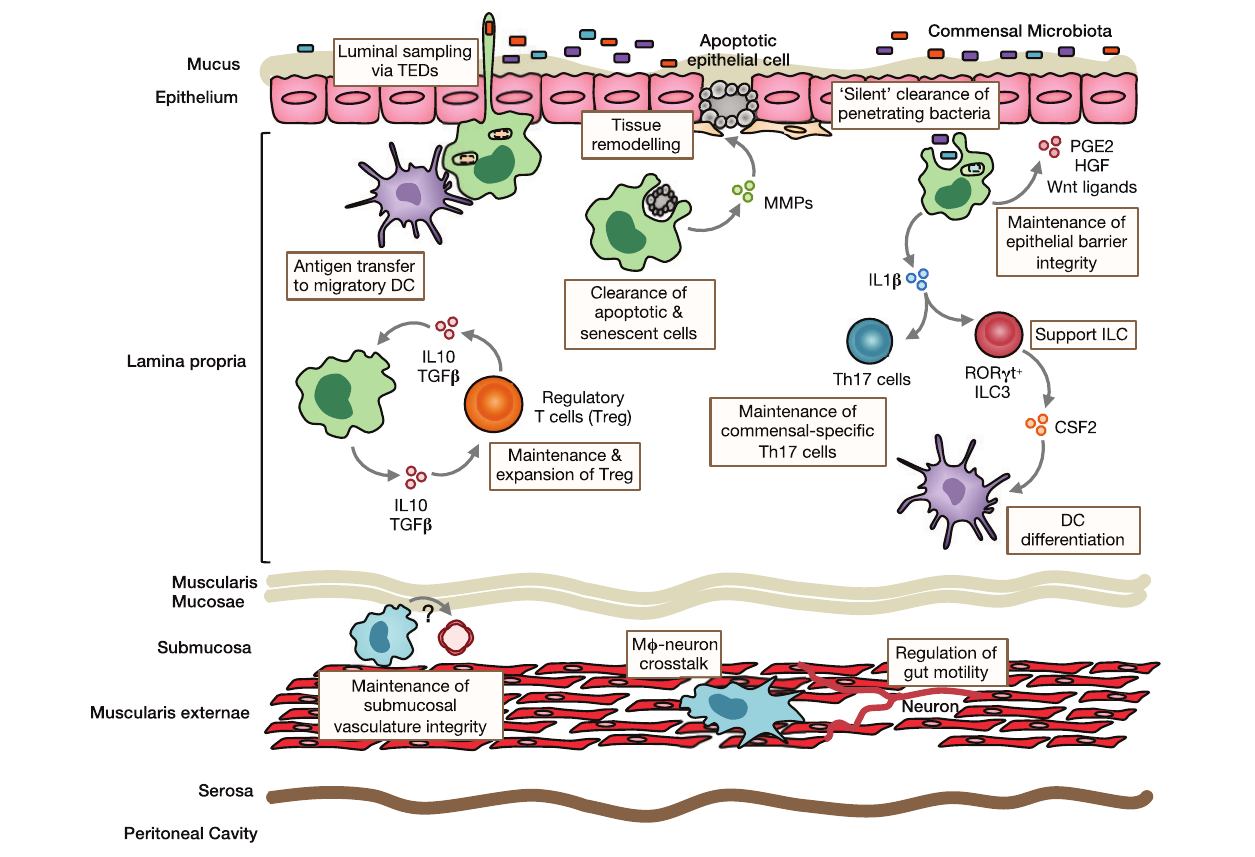
FIGURE 1 | Homeostatic functions of intestinal macrophages. Intestinal lamina propria (LP) macrophages are highly phagocytic and are responsible for clearing apoptotic and senescent epithelial cells. Through their expression of tissue-remodeling metalloproteinases and secretion of factors that stimulate epithelial stem cell renewal, such as prostaglandin E2 (PGE2), hepatocyte growth factor (HGF) and Wnt ligands, they promote epithelial integrity. Their position under the epithelial monolayer and their bactericidal activity, mean LP macrophages are ideally placed to capture and destroy any bacteria that breach the barrier. They may also send cellular processes across the epithelial barrier to sample luminal contents. Macrophages can transfer acquired antigen to migratory dendritic cells (DCs) for presentation to T cells in the draining mesenteric lymph nodes. Through their production of immunoregulatory cytokines, such as IL10 and TGF β , they maintain and facilitate secondary expansion of regulatory T cells (Tregs) locally in the LP. In a similar manner, they support Th17 cells and ILC3s through their production of IL1 β , which is induced by exposure to the microbiota or its derivatives. Macrophages are also present in deeper layers of the gut wall, including the submucosa and muscularis externae. Submucosa macrophages are thought to support the integrity of the submucosal vasculature, although the factors involved in this interaction remain unclear. Muscularis macrophages participate in bidirectional crosstalk with sympathetic neurons of the enteric nervous system and influence gut